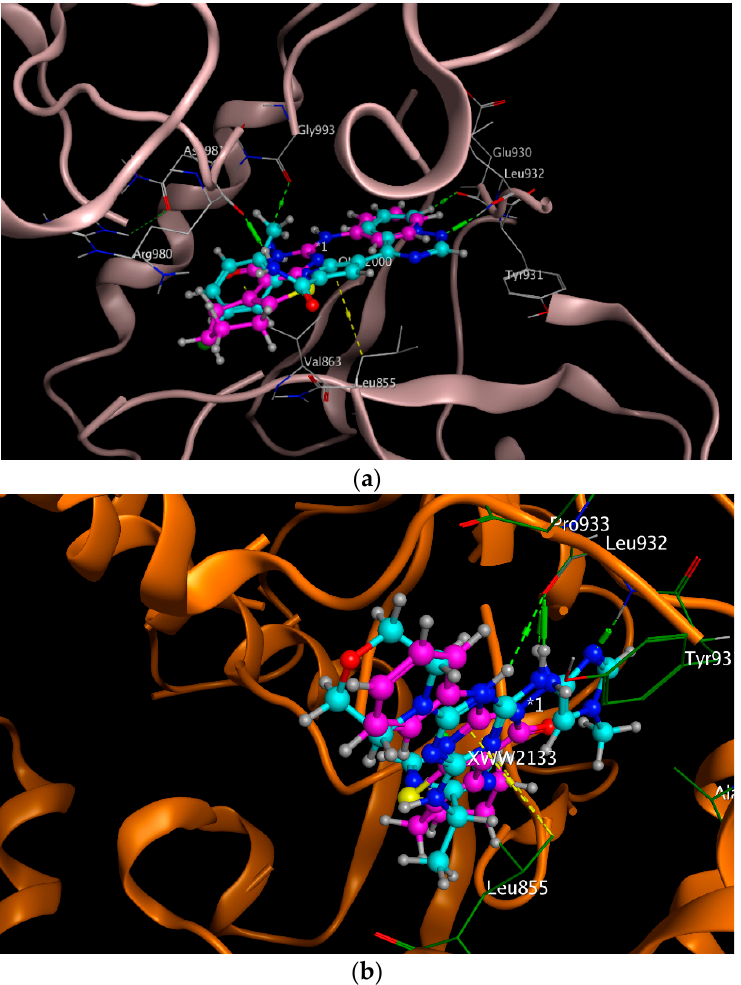
Figure 4. Compound 3 (magenta ball and stick) aligned with the co-crystalized ligand (cyan ball and stick) at the target protein: ( a ) PDB: 5AEP, ( b ) PDB: 4C62. Interactions with H-bonds are in green, and with H- pi are in yellow.